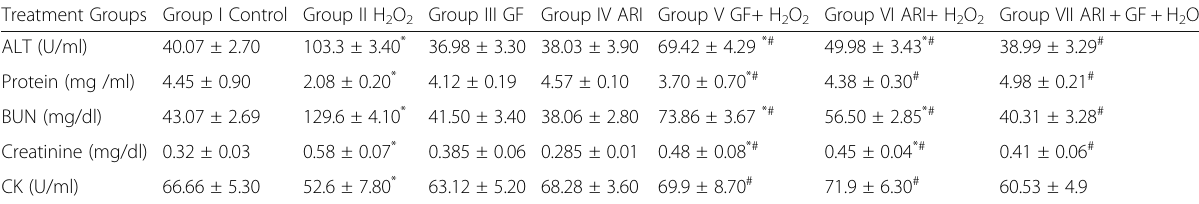
Table 2 Effect of H 2 O 2, GFJ, ARI induced alterations alone and in combination, on the levels of enzymatic and non-enzymatic antioxidant contents in serum of control and treated mice